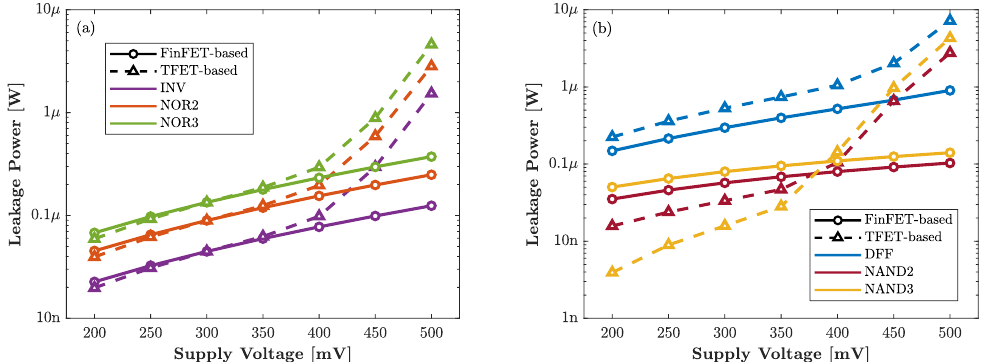
Figure 6. Leakage power over a wide supply voltage range for TFET and FinFET-based logic gates divided in ( a ) INV, NOR2, and NOR3 and ( b ) DFF, NAND2, and NAND3.